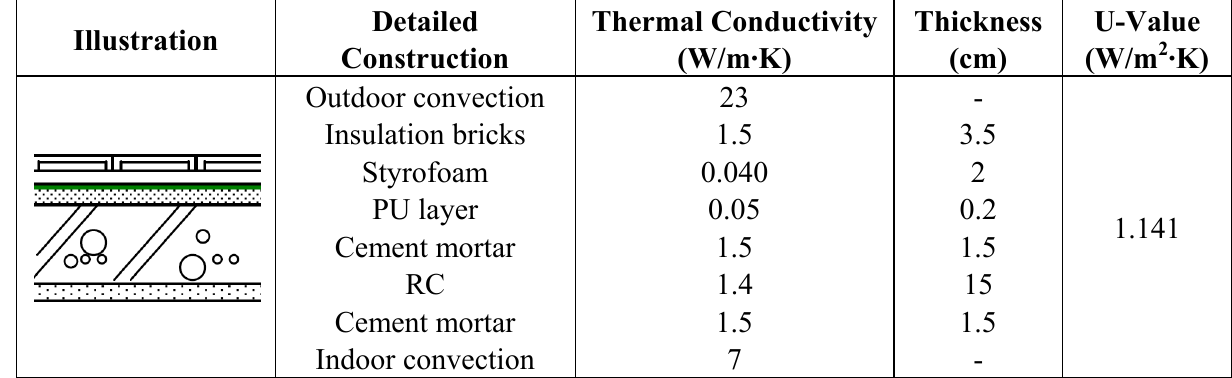
Table 1. Details of the RC roof and the thermal properties of each layer of material.